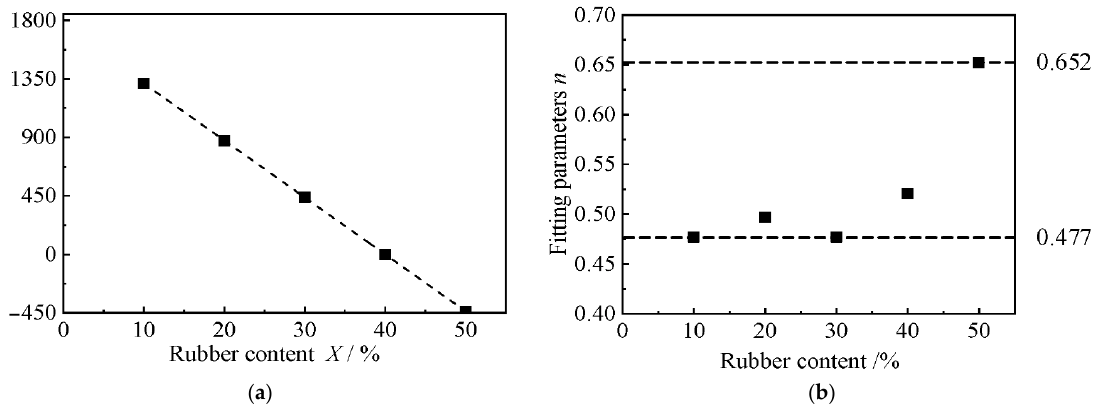
Figure 21. The relationship between fitting parameters K and n and rubber content. ( a ) Fitting parameters K , ( b ) Fitting parameters n .